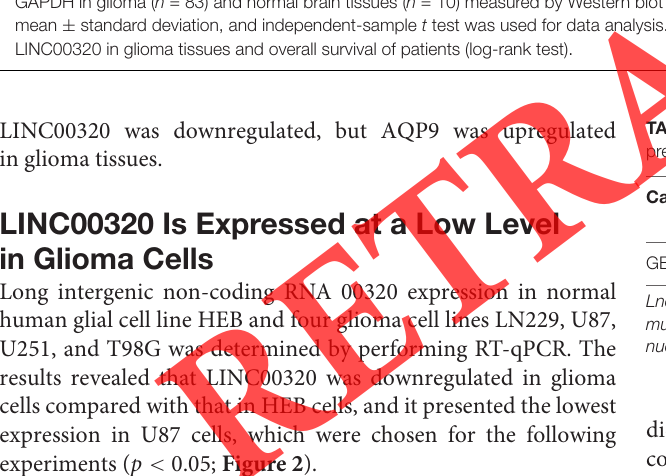
FIGURE 1 | LINC00320 was expressed at a low level, and AQP9 was expressed at a high level in glioma tissues. (A) Volcano map representing differentially expressed lncRNAs related to glioma. The abscissa indicates log fold change, and the ordinate indicates log10 p value. Each point in the figure represents a gene, the red dots indicate upregulated genes, and the green dots indicate downregulated genes. (B) The expression of LINC00320 in gliomas and normal samples evaluated by differential analysis. (C) The expression of LINC00320 in glioma ( n = 83) and normal brain tissues ( n = 10) determined using RT-qPCR normalized to β -actin. (D) Overall survival curve of patients with glioma regarding the expression pattern of LINC00320 plotted using Kaplan–Meier method. (E) The mRNA expression of AQP9 in glioma ( n = 83) and normal brain tissues ( n = 10) detected using RT-qPCR normalized to β -actin. (F) AQP9 protein expression normalized to GAPDH in glioma ( n = 83) and normal brain tissues ( n = 10) measured by Western blot analysis. * p < 0.05 vs. normal brain tissues. Data were expressed as mean ± standard deviation, and independent-sample t test was used for data analysis. Kaplan–Meier was used to analyze the relationship between expression of LINC00320 in glioma tissues and overall survival of patients (log-rank test).